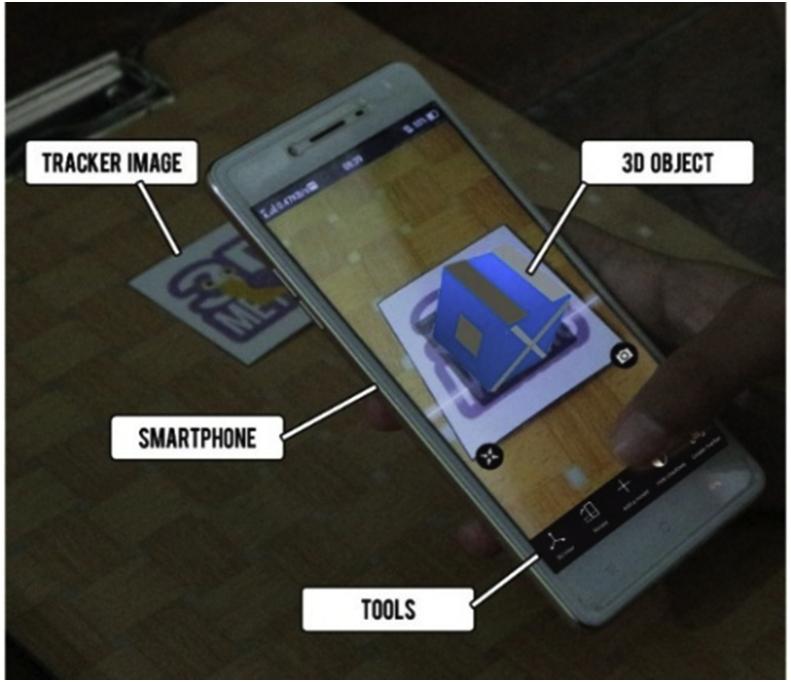
Tools in 3Dmetric.